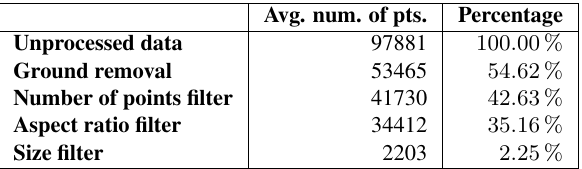
Table 1. Data reduction in